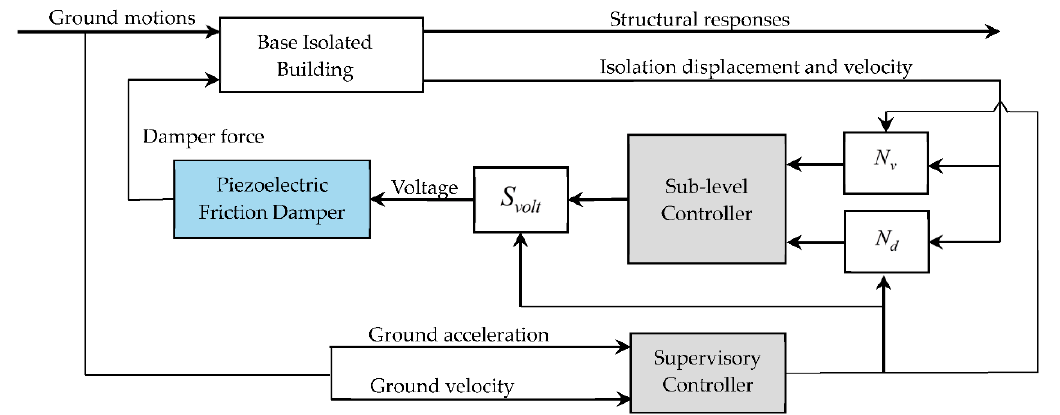
Figure 4. Block diagram of the self-tuning fuzzy control strategy.